Question: Produce a descriptive caption suitable for publication.
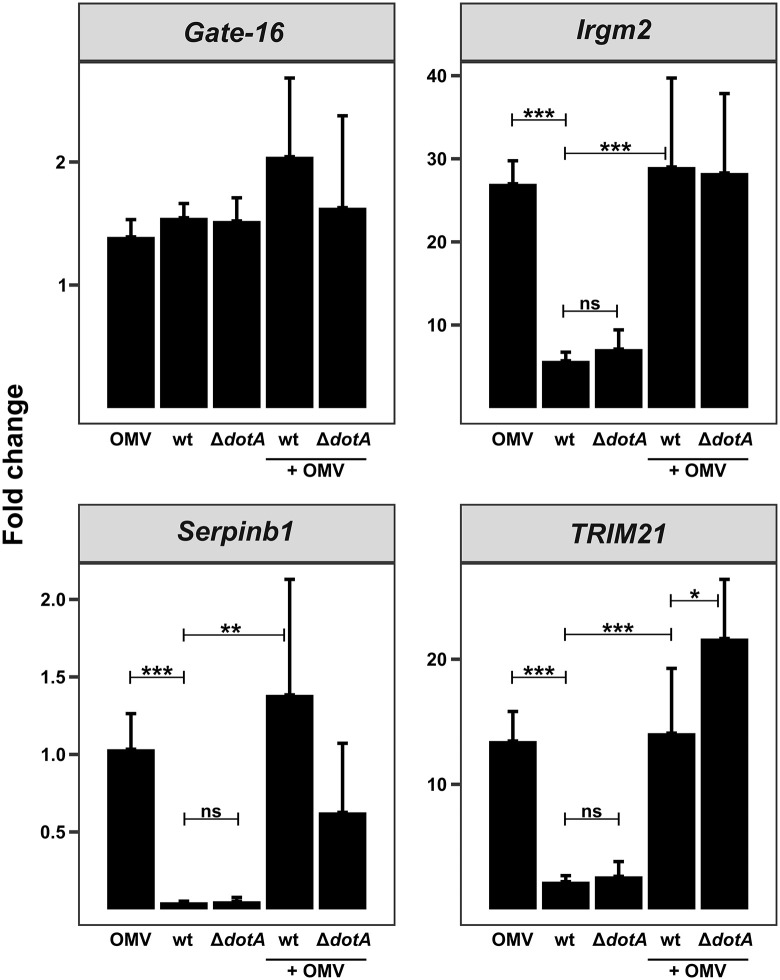
Answer: TRIM21 might be implicated in the lack of non-canonical inflammasome activation by C. burnetii , unlike GATE-16, Irgm1-3, or SerpinB1. BMDM were stimulated with OMVs for 8h, infected with C. burnetii wt or Δ dotA for 32h, or for 24h with subsequent OMV stimulation for 8h. The fold change in mRNA transcript level of the indicated targets was calculated relative to uninfected BMDM. Mean ± SD, n = 4, One-Way-ANOVA with Bonferroni post-test. **p < 0.01, ***p < 0.001.